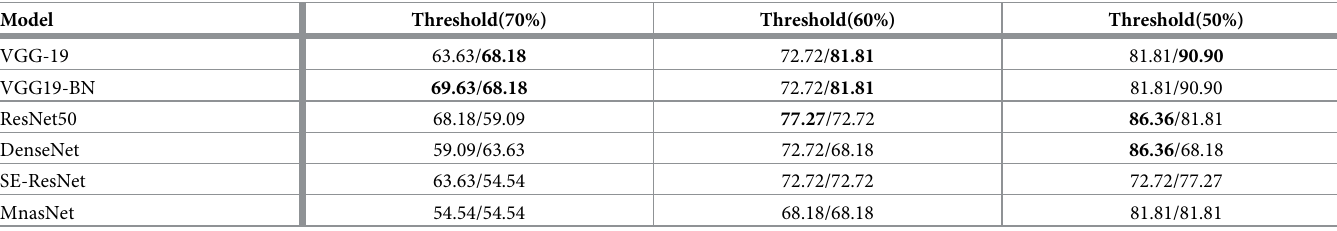
Table 5. Sequence-based